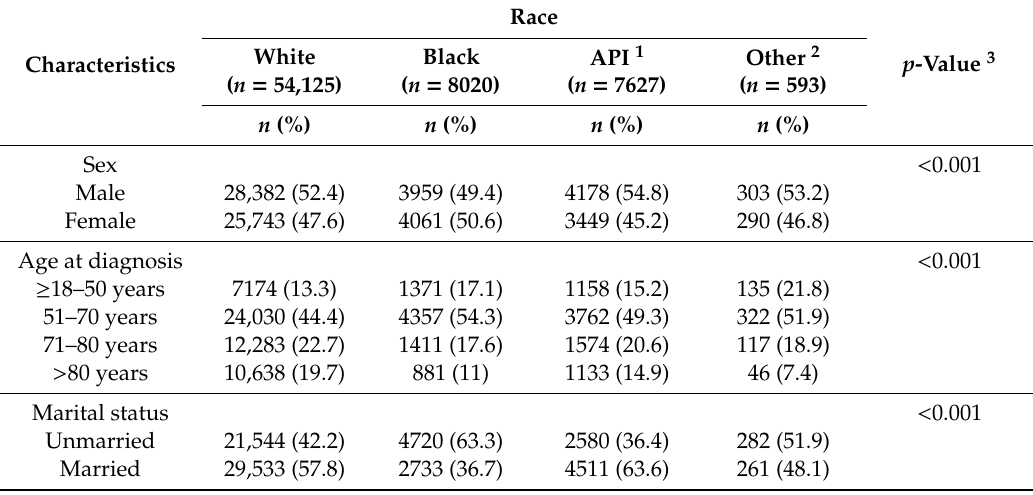
Table 1. Characteristics of colorectal cancer patients according race in the US during 2007 and 2014.